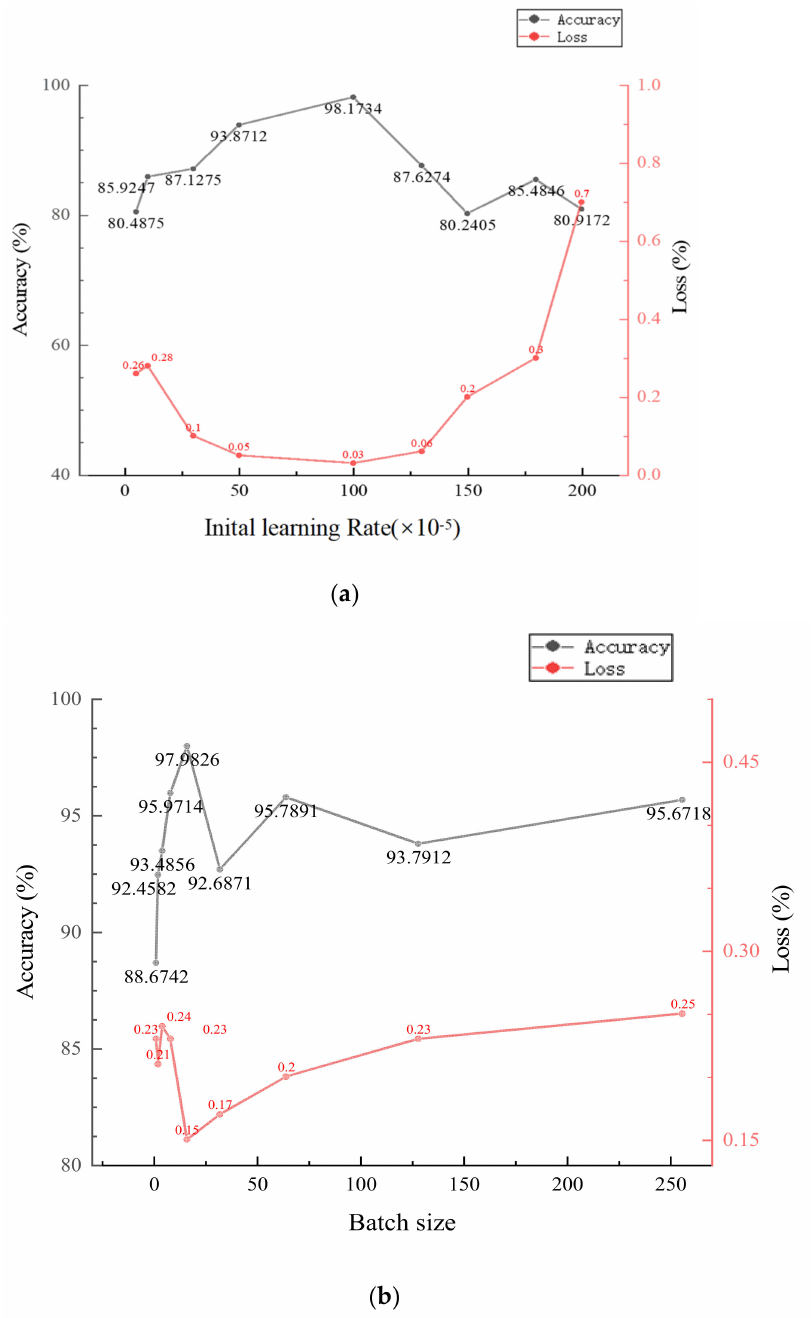
Figure 9. The effect of hyperparameters on accuracy and loss. ( a ) The effect of initial learning rate value on accuracy value and loss; ( b ) The effect of batch size value on accuracy and